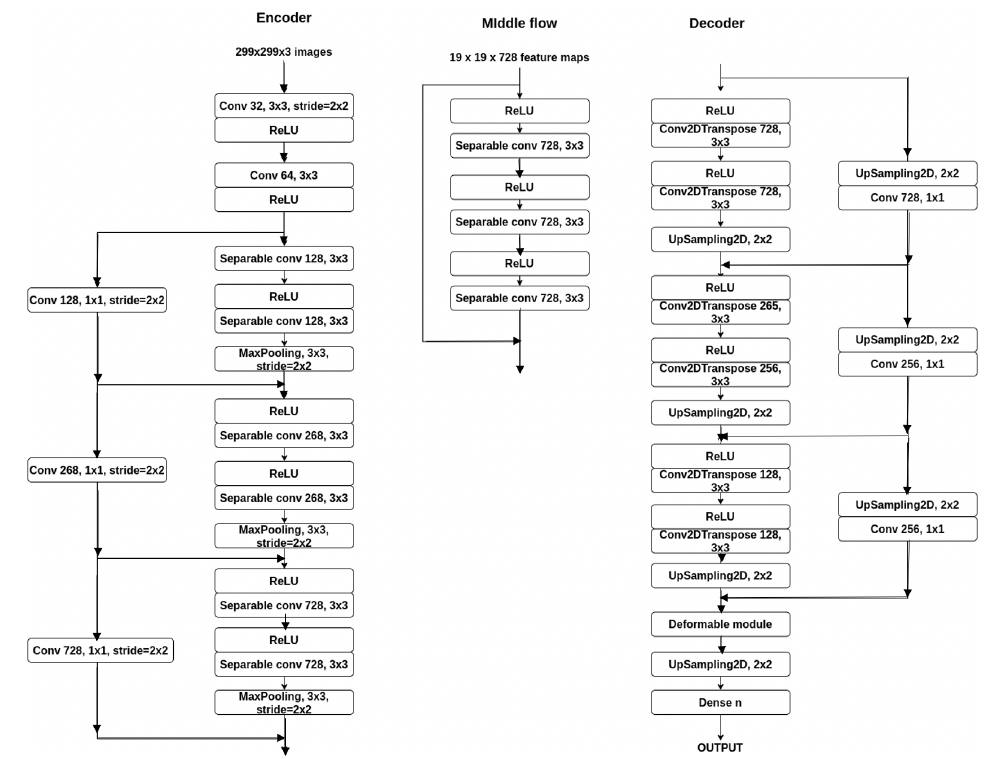
Figure 2. The proposed architecture, with resolution 299 × 299 and different number of modules for the middle flow (between 2 and 8). Table 7. Results of the architecture with transfer learning on Pascal VOC 2012 dataset (image resolution 299 × 299).